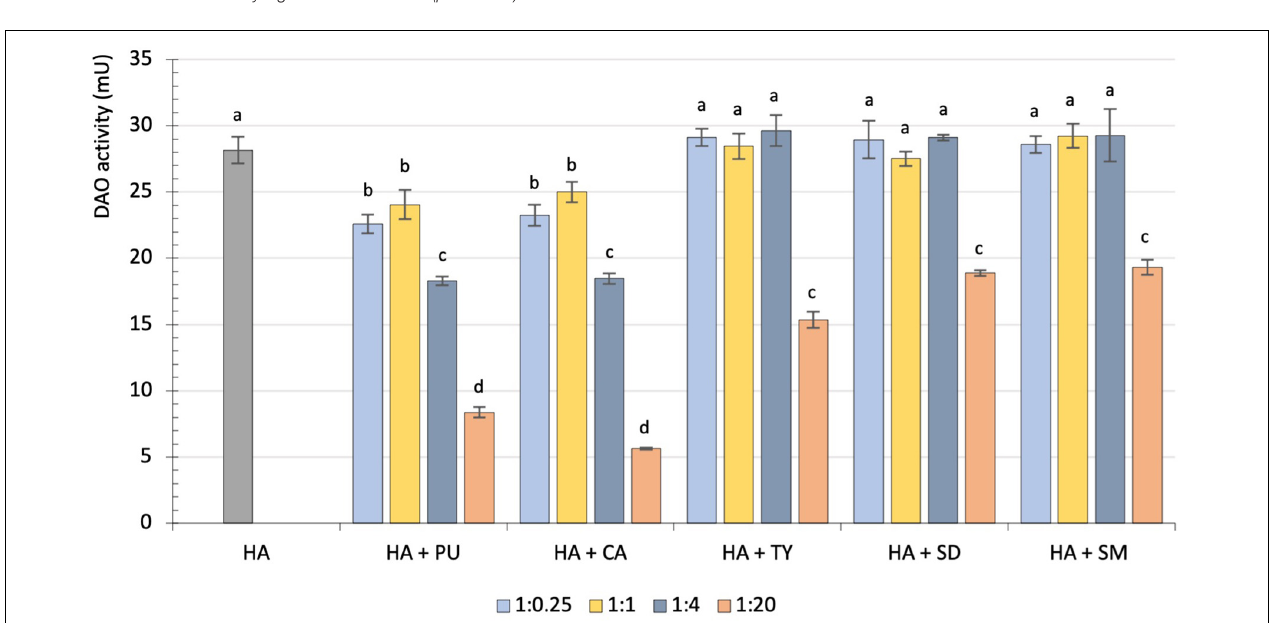
FIGURE 1 | Comparison of diamine oxidase (DAO) activity (mU) on histamine by itself (gray) and on histamine together with different proportions of putrescine, cadaverine, tyramine, spermidine or spermine: 1:0.25 (light blue), 1:1 (yellow), 1:4 (dark blue) and 1:20 (orange). Different letters denote statistically significant differences ( p < 0.05). HA, Histamine; PU, Putrescine; CA, Cadaverine; TY, Tyramine; SD, Spermidine; SM, Spermine.